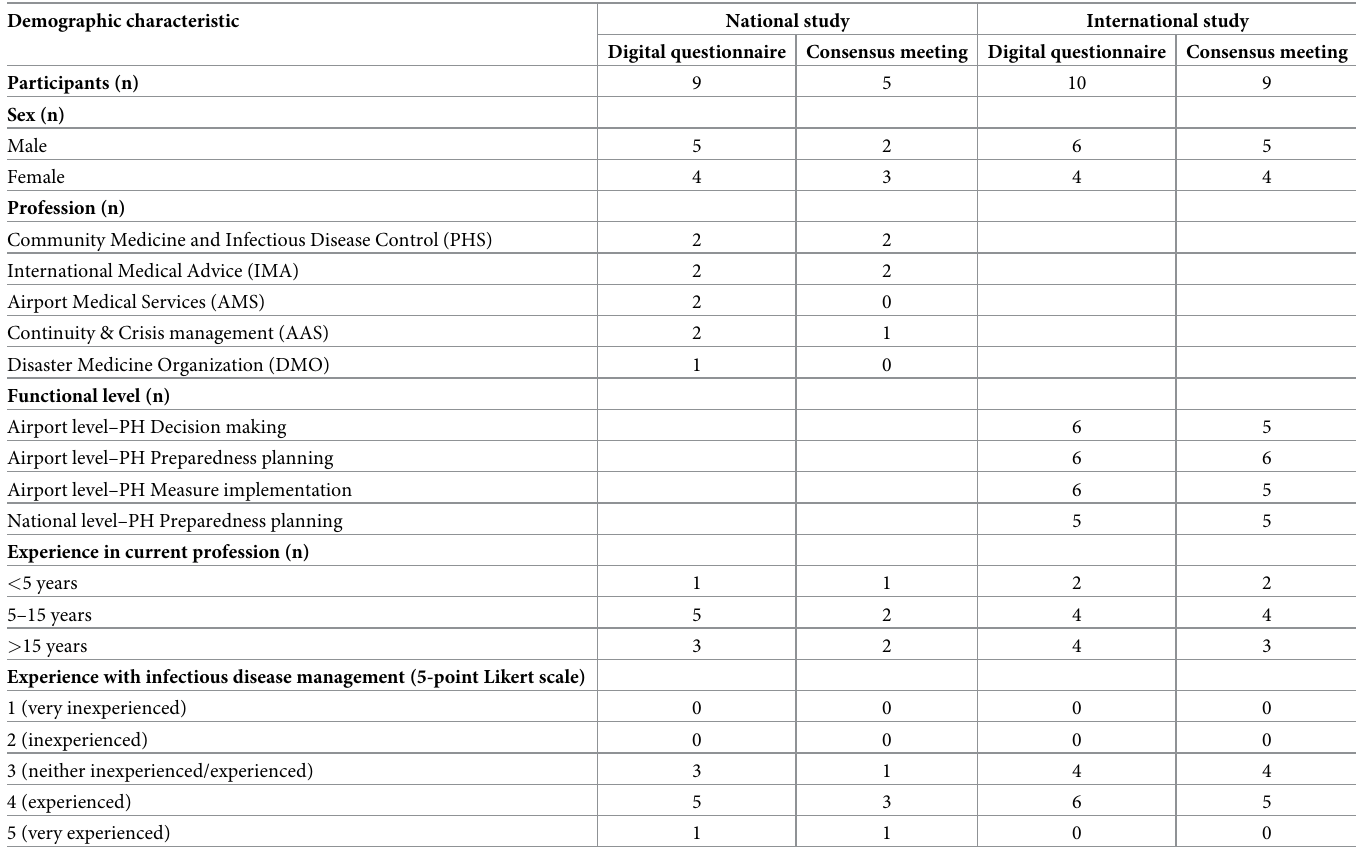
Table 2. Demographic characteristics of